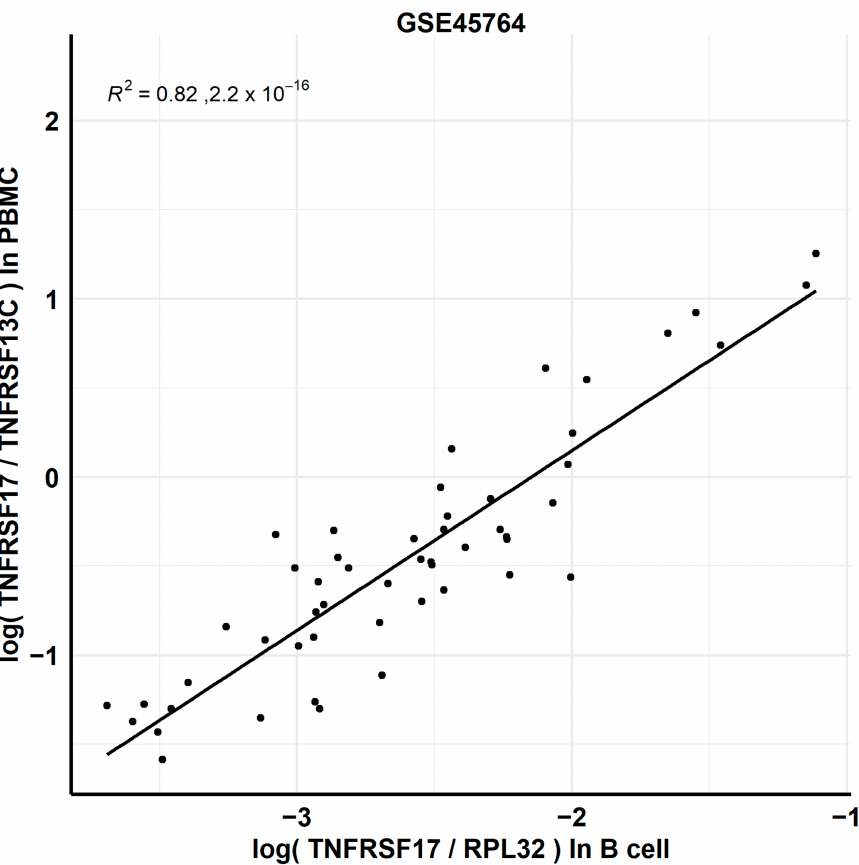
Figure 3. High level of correlation between new biomarker, Direct LS-TA biomarker of target gene TNFRSF17 by obtaining a ratio of TAs of two genes (TNFRSF17 and TNFRSF13C) in PBMC samples ( Y -axis) and TA of TNFRSF17 in purified B lymphocytes (ground-truth, X -axis). R 2 = 0.82 ( p -value < 2.2 × 10 − 16